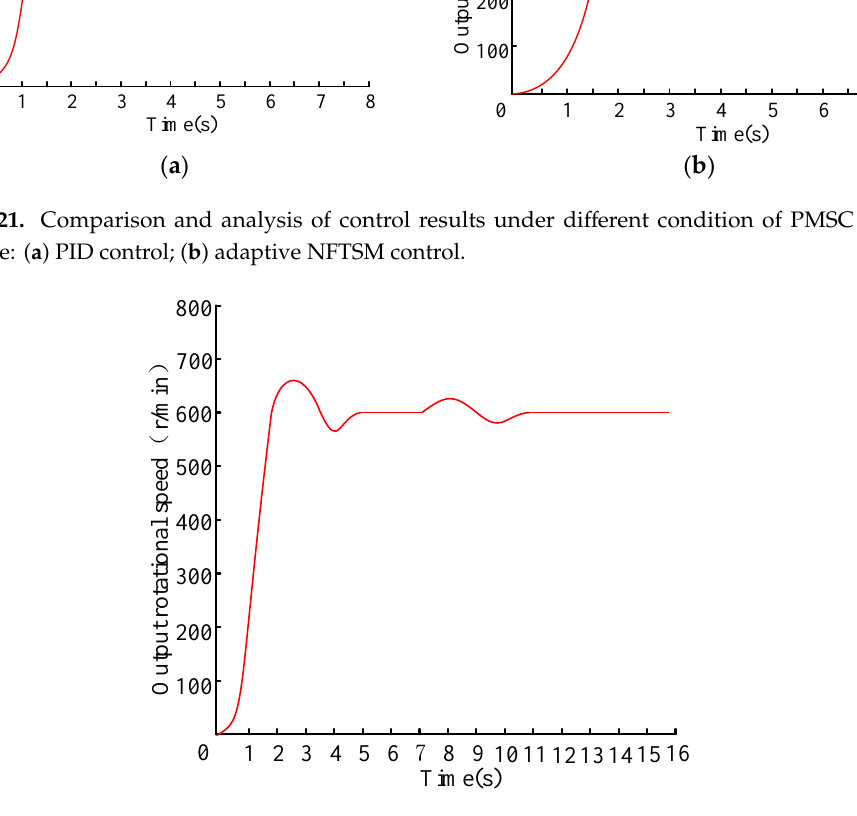
Figure 21. Comparison and analysis of control results under different condition of PMSC speed response: ( a ) PID control; ( b ) adaptive NFTSM control.